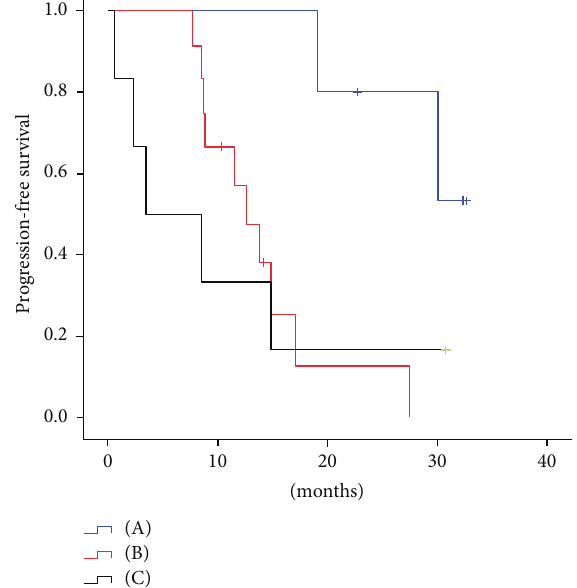
Figure 2: Kaplan-Meier curves for progression-free survival of the groups described in Figure